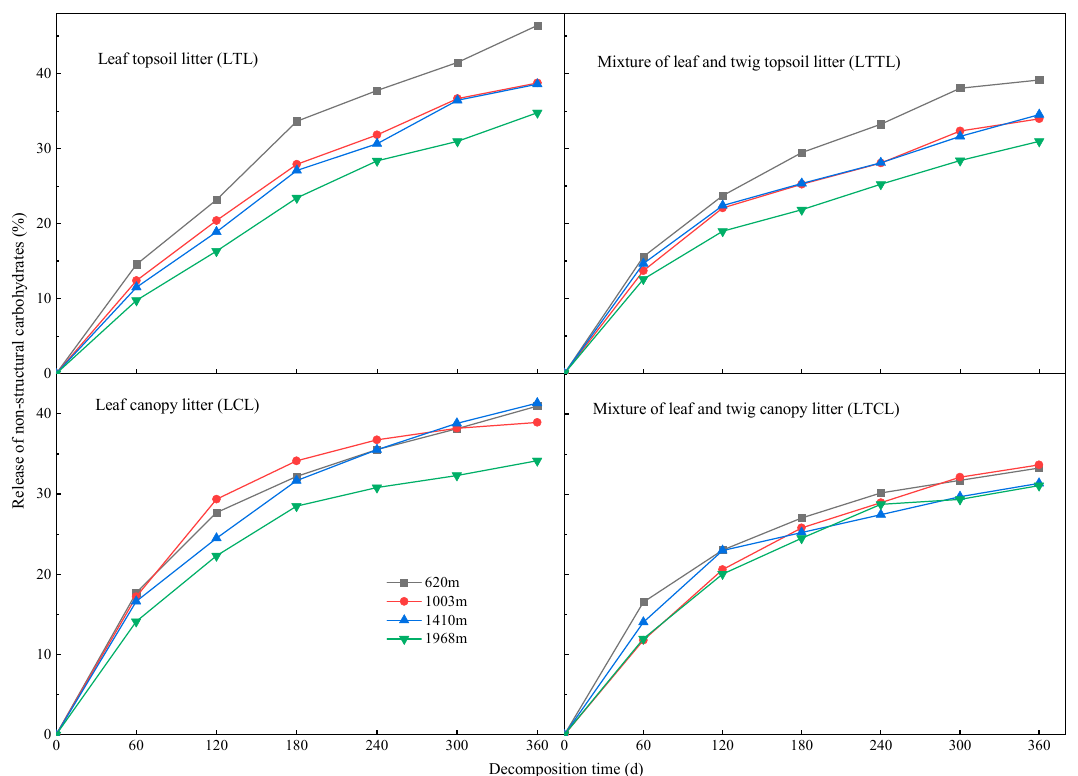
Figure 3. Cumulative release of NSC in Chinese fir topsoil litter and canopy litter at different altitudes.